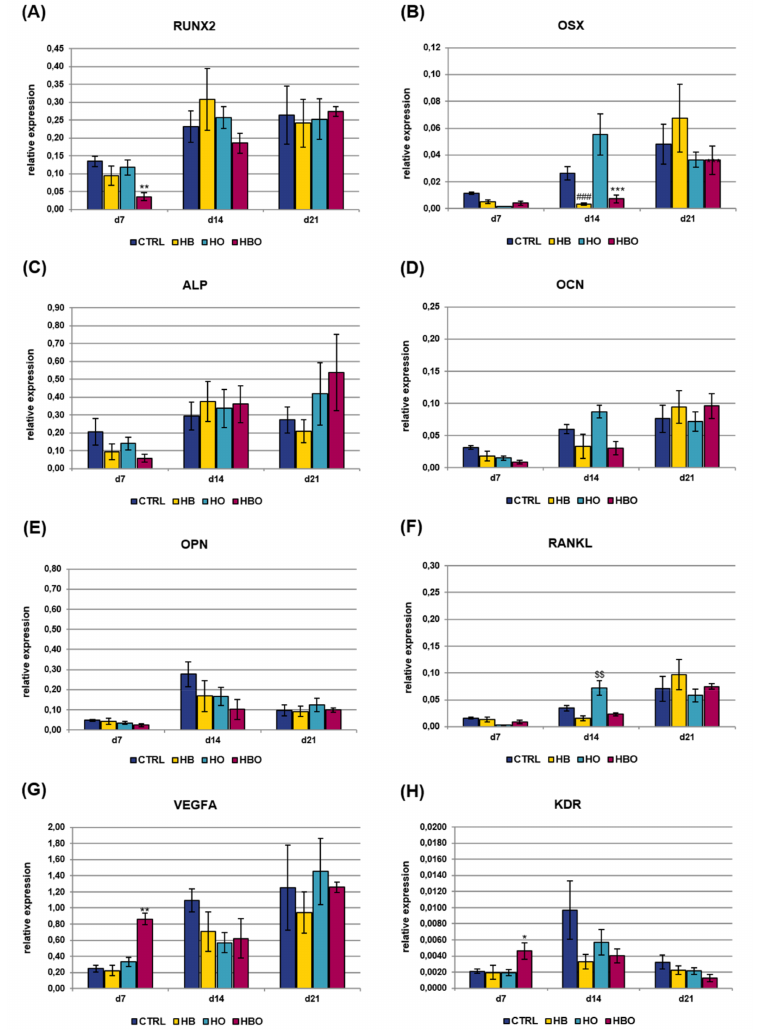
Figure 7. Gene expression profile of osteogenic and vasculogenic markers in hADSCs after HBO treatment in the presence of inflammation. Expression of ( A ) RUNX2; ( B ) OSX; ( C ) ALP; ( D ) OCN; ( E ) OPN; ( F ) RANKL; ( G ) VEGFA; and ( H ) KDR measured by real-time PCR. Data are expressed as mean ± SD of the target gene versus reference gene (TFRC) ratio and represented by 2deltaCt. * p < 0.05, **, $$ p < 0.01, and ***, ### p < 0.001 mark significant changes in gene expression level compared to the control within the same measurement